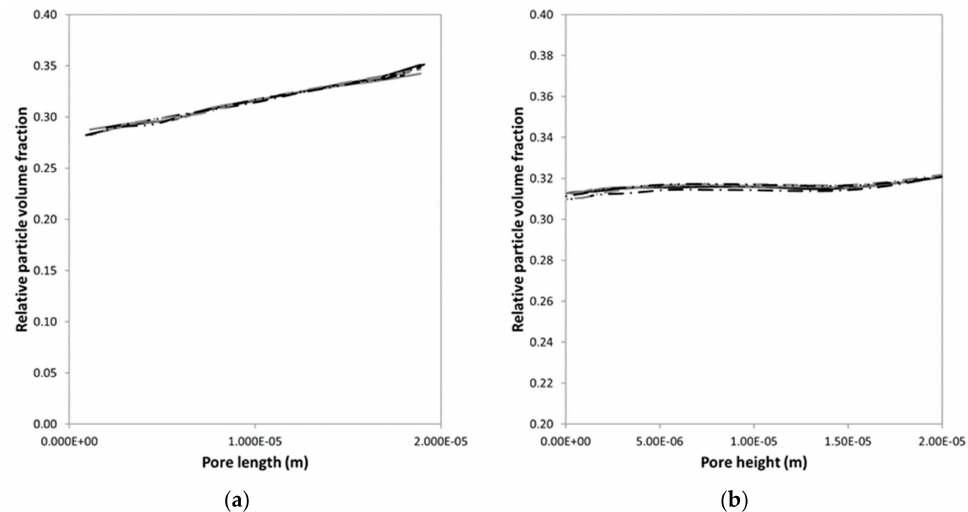
Figure A4. Grid refinement study for case 4: the length and height of the pore. The relative particle volume fraction versus the channel height, measured at the center of the pore in the vertical ( a ) and horizontal ( b ) direction. The grid cell number for both the height (h) and the length (l) is changed: h = 5 and l = 9 (black solid line); h = 7 and l = 9 (grey solid line); h = 9 and l = 9 (black dashed line); h = 11 and l = 9 (grey dashed line); h = 9 and l = 5 (black dashed-dotted line), h = 9 and l = 7 (grey dashed-dotted line) and h = 9 and l = 7 (black dashed-double dotted line).